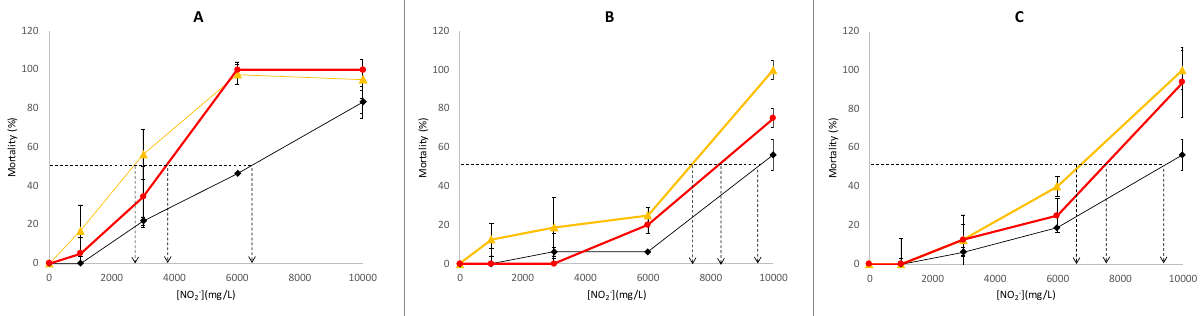
Figure 2. The results of the lethality assays. ( A ): dose – response curves with no ascorbic acid pre-exposure group; ( B ): the dose – response curves of the 5 mM ascorbic acid pre-exposure group; ( C ): the dose – response curves of the 10 mM ascorbic acid pre-exposure group. Dotted lines mark LC 50 for each treatment. AA: yellow triangles; PA: black diamond; PP: red circles.